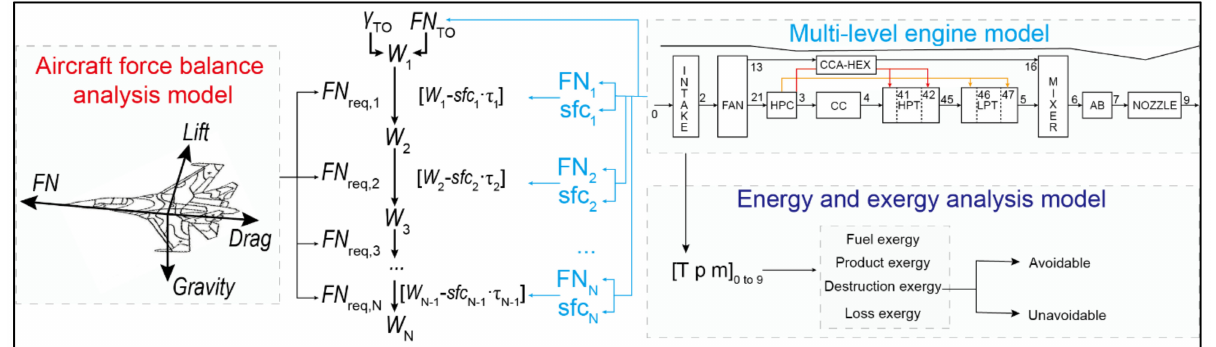
Figure 2. The logic schematic of aircraft-engine integrated